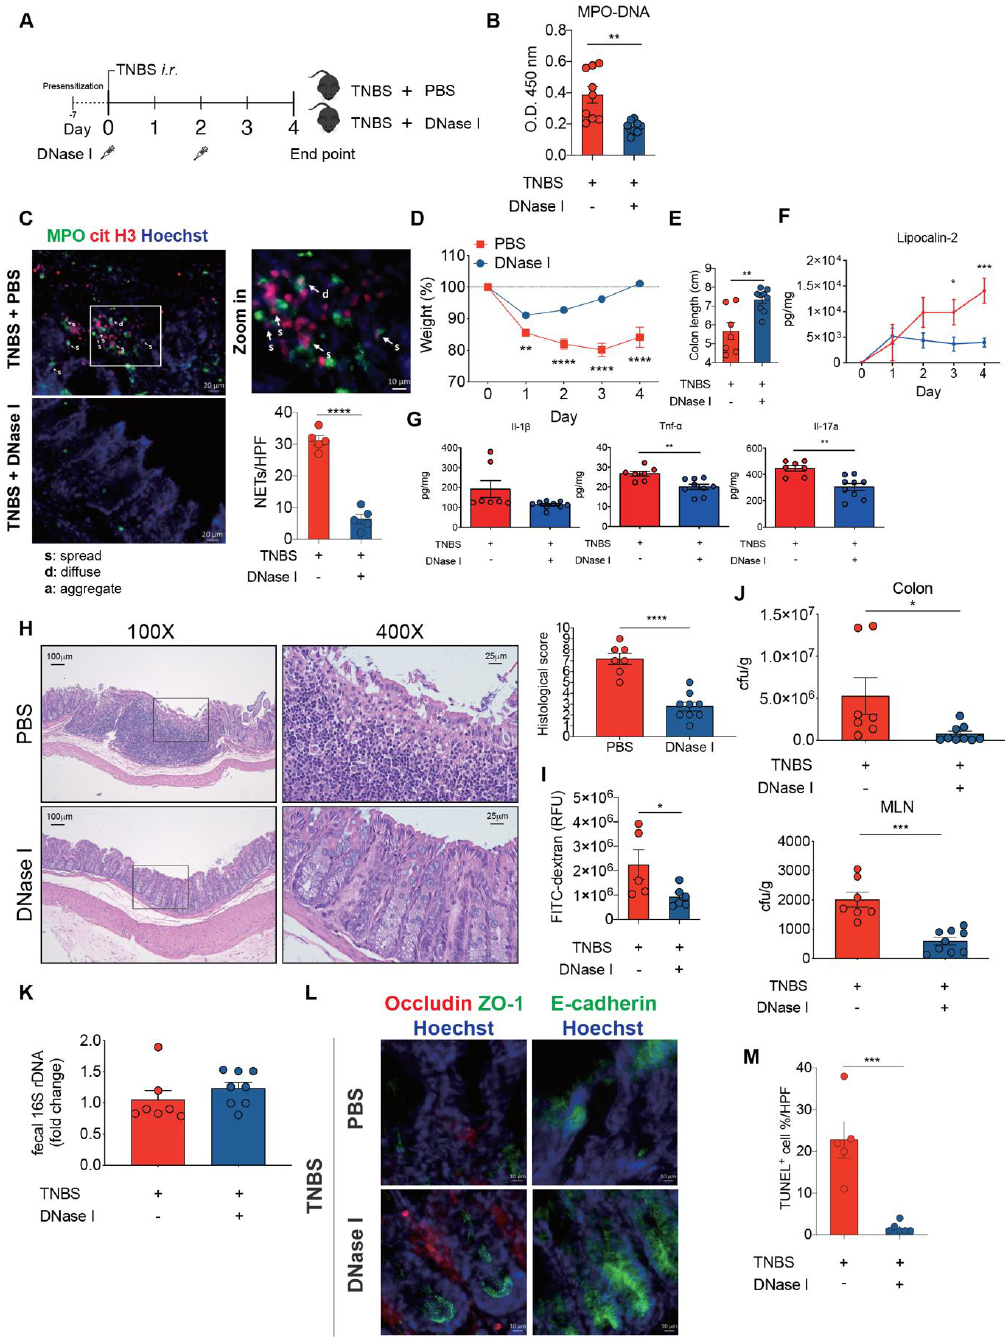
Figure 6. DNase I administration reduces intestinal inflammation and restores intestinal barrier function in mice with 2,4,6-Trinitrobenzenesulfonic acid (TNBS)-induced colitis. ( A ) Schematic overview of the experiment. Colitis was induced by the intra-rectal ( i.r. ) injection of TNBS into pre-sensitized C57BL/6 mice. PBS or 250 U/dose DNase I was i.v. administered to mice on day 0 and 2. ( B ) NET release, measured in colon homogenates of PBS- or DNase I-administered TNBS-induced colitis mice on day 4, by using MPO-DNA complex ELISA. n = 9 mice per group. ( C ) Representative NET release (white arrows) in the colon of PBS control or DNase I-treated mice 4 d after TNBS administration, assessed by immunofluorescence microscopy of myeloperoxidase (MPO; green), citrullinated histone H3 (citH3; red), and Hoechst 33342-stained DNA (blue). n = 5 mice per PBS group and n = 5 mice per DNase I